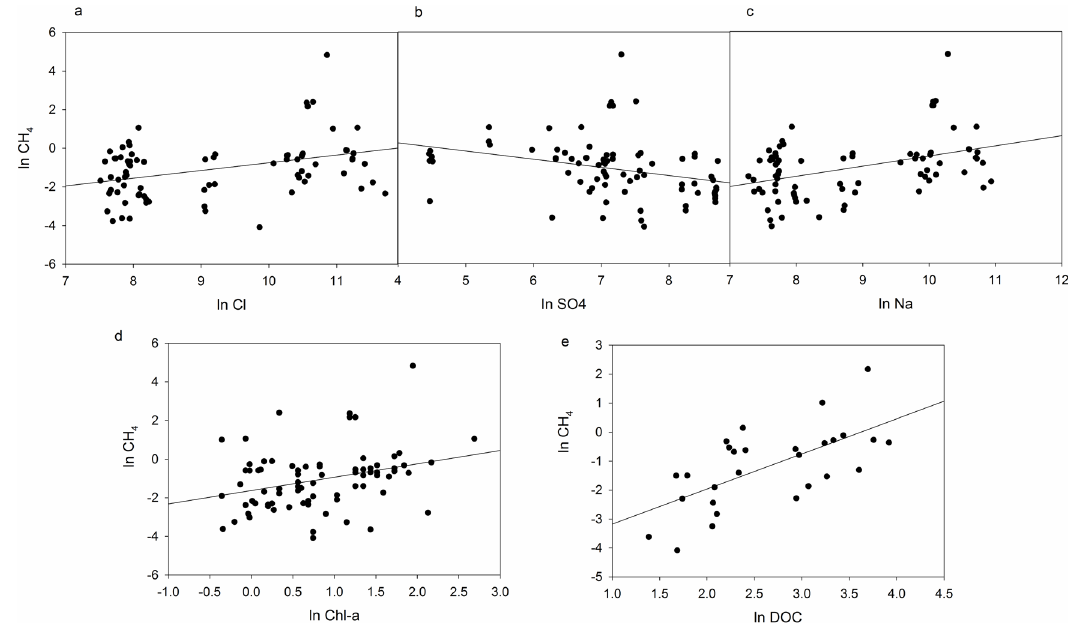
Fig 6. Individual relationships between predictors of methane (CH 4 ) in Greenland lakes. All lines represent significant regression models. Statistics for each relationship can be found in Table 3.